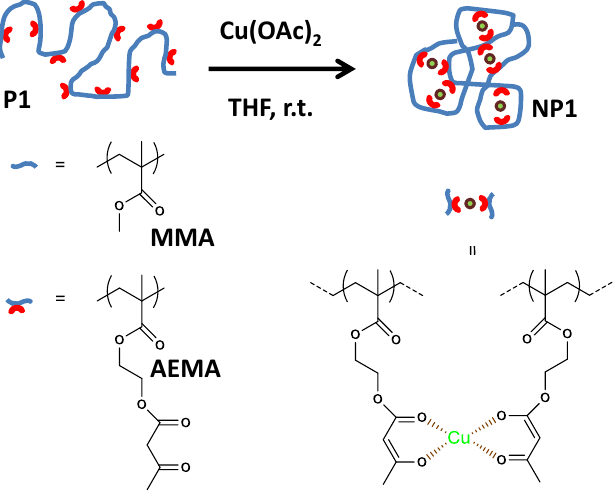
Figure 1. Schematic illustration of the formation of catalytic single-chain nanoparticle (SCNP) NP1 from functional precursor polymer P1 via intra-chain copper(II)-complexation (reprinted from [14] with permission, Copyright American Chemical Society, 2014). THF = tetrahydrofuran; MMA = methyl methacrylate; AEMA = (2-acetoacetoxy)ethyl methacrylate.